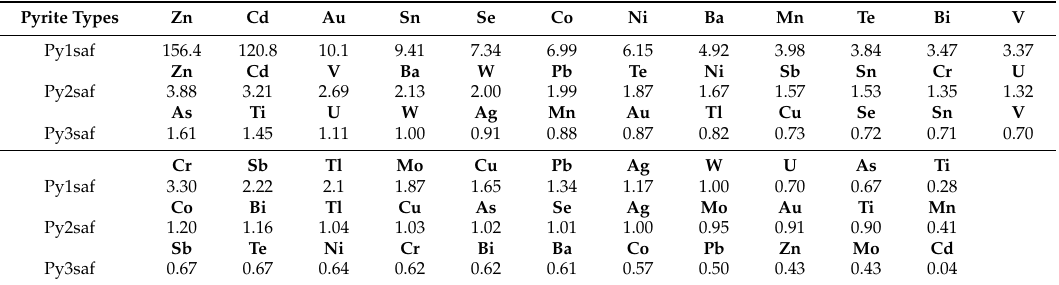
Table 2. Range of accumulation of trace elements in pyrite nodule from the Saf’yanovskoe massive sulfide deposit (median element / median all sulfides ).